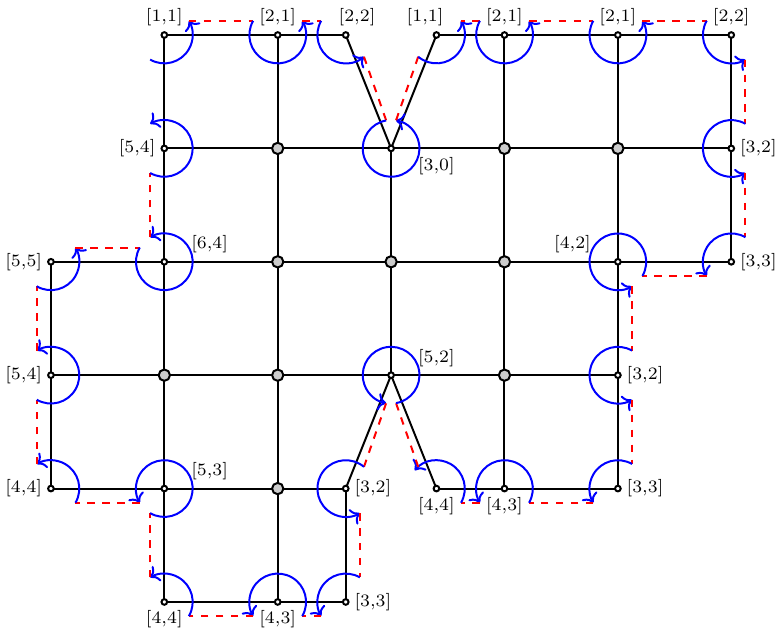
Figure 14 . The (cid:12)shnet graph with irregular boundary depicted in (cid:12)gure 12 is a Yangian invariant, i.e. it is an eigenfunction of the monodromy with the indicated inhomogeneities [ (cid:14) + assignment of inhomogeneities follows the rule in (cid:12)gure